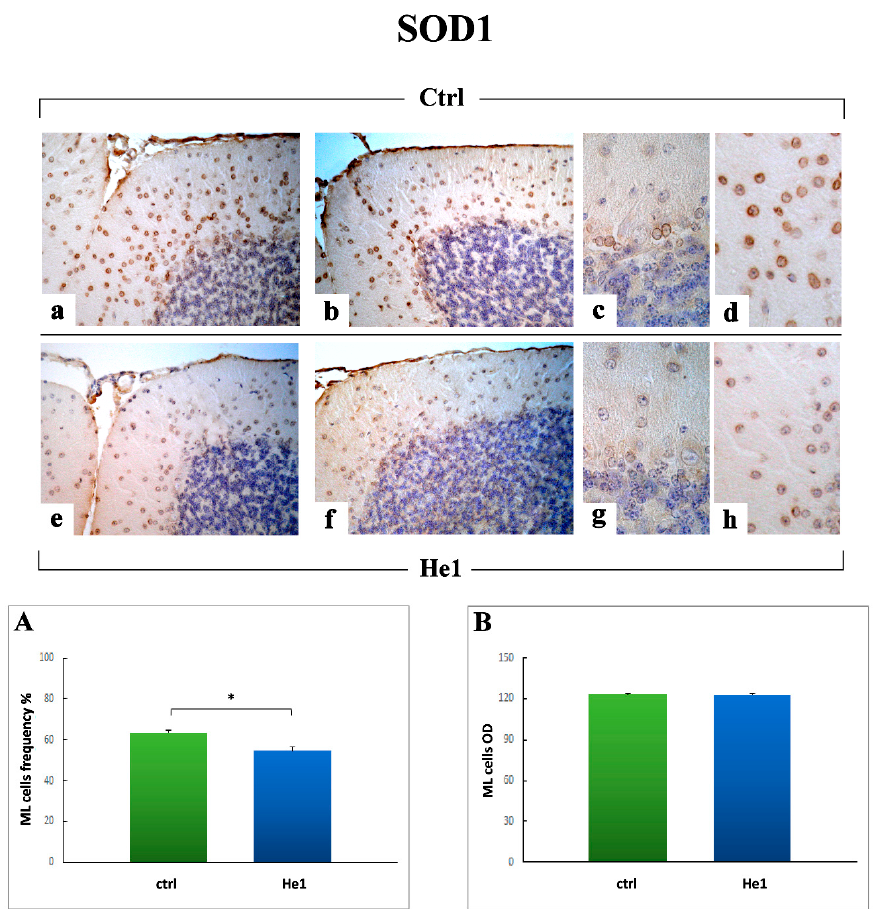
Figure 11. SOD1-Immunohistochemical labeling in untreated ( a – d ) and He1-treated mice ( e – h ). Light microscopy magnification: 40× ( a , b , e , f ); 100× ( c , d , g , h ). Panels ( A , B ) Histograms illustrating the quantitative measurement of SOD1 immunopositive cell frequency and OD, respectively. p values calculated by unpaired Student’s t -test: * p < 0.05.